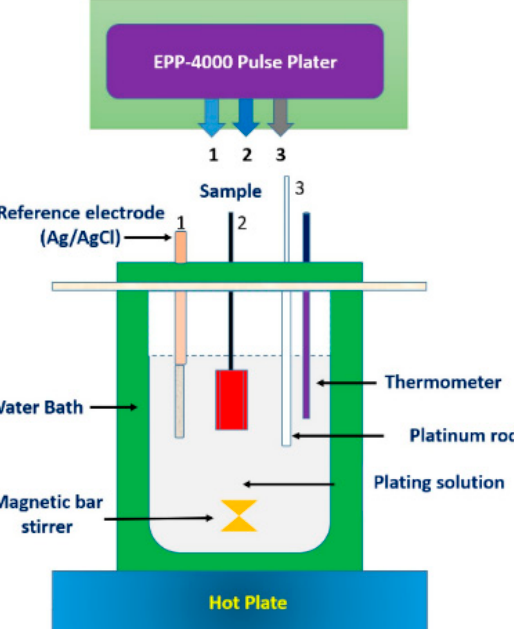
Figure 1. Experimental arrangement showing plating cell, electrodes, and power supply. The numbers 1, 2, and 3 indicate the connections to the EPP-4000 instrument.